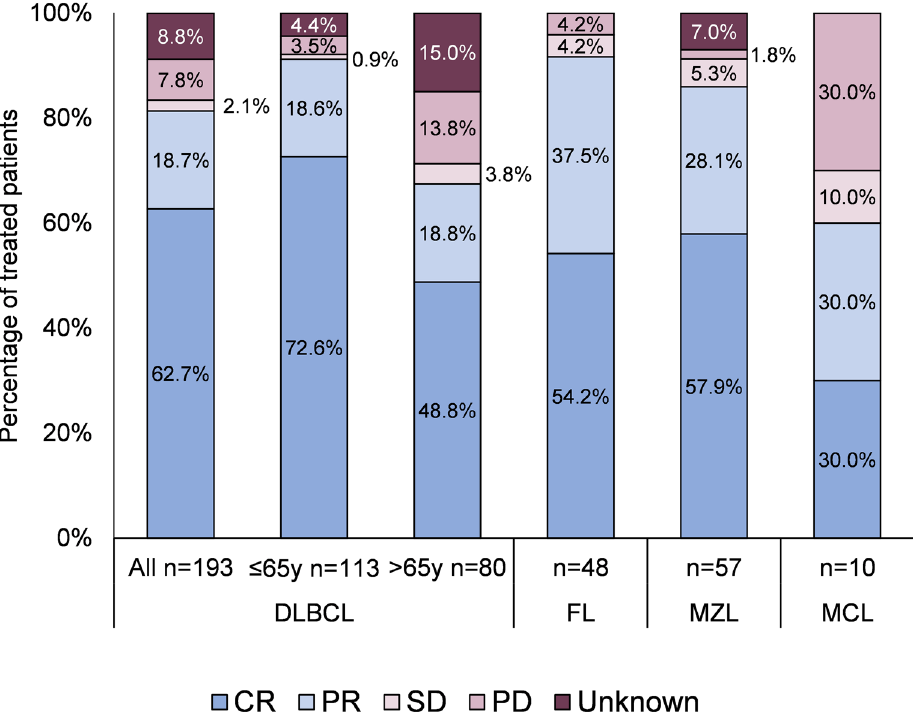
Figure 2. Response to 1st-line treatment among B-NHL subtypes. CR, complete response; DLBCL, diffuse large B-cell lymphoma; FL, follicular lymphoma; MCL, mantle cell lymphoma; MZL, marginal zone lymphoma; PD, progressive disease; PR, partial response; SD, stable disease. *1st-line treatment limited to R-CHOP-like/ CHOP or R-COP in patients with DLBCL; R-CHOP-like/ or R-COP/COP in patients with FL; all administered treatments for other subtypes. Clinical response criteria differ for WM or CLL/SLL and these subtypes are not included in this graph. Data are tabulated and drug abbreviations explained in Table